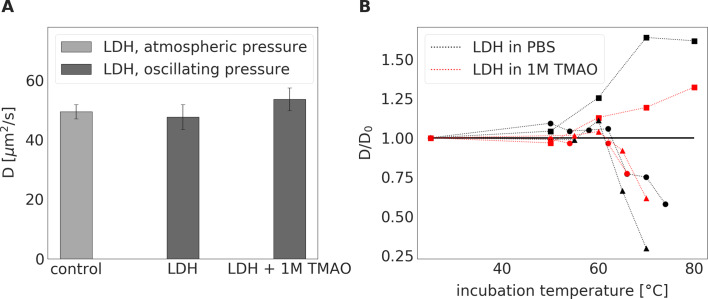
LDH incubated at a constant atmospheric pressure for 24 hrs or LDH exposed to oscillating pressure for 24 hrs with or without TMAO.(A) - Diffusion coefficient of LDH incubated either in PBS buffer at a constant atmospheric pressure and room temperature (serving as a control) or exposed to pressure oscillation for 24 hrs either in PBS buffer or in 1 M TMAO solution in PBS buffer at room temperature. Irrespective of the presence of 1M TMAO, 24-hour incubation under oscillating pressure did not cause dissociation, denaturation, or aggregation of LDH. ( B) – Relative diffusion coefficient (diffusion coefficient D divided by its value in PBS buffer at room temperature D0) of LDH exposed to elevated temperatures for 15 min either in PBS buffer (black symbols) or 1 M TMAO solution in PBS (red symbols). Symbol shapes differentiate between three independent measurement series (series 1 (3nM of LDH) – squares, series 2 (30nM of LDH) – circles, series 3(300nM) – triangles). In series 1, we observed an increase in the relative diffusion coefficient, suggesting degradation of LHD tetramer structure to monomers. In series 2 and 3, an increase in diffusion coefficient was followed by a decrease in diffusion coefficient suggesting the degradation of LDH followed by the aggregation of the LDH monomers. The presence of TMAO shifted the threshold of change in relative diffusion coefficient towards higher temperatures.Figure 10—source data 1.LDH incubated at a constant atmospheric pressure for 24 hrs or LDH exposed to oscillating pressure for 24 hrs with or without TMAO.